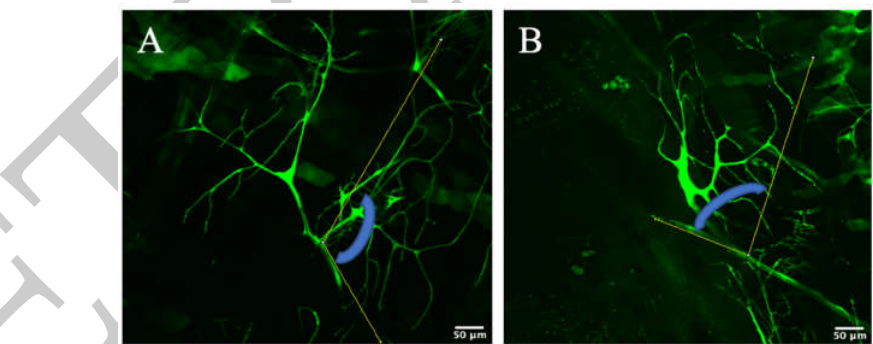
Figure 6. Examples of angle° analysis for branching morphogenesis. The angle is indicated by the blue arc that is drawn between the first yellow line, which is a constant line intersecting the two terminal cells, and the second yellow line encompassing the furthest visible branch for the terminal cell of interest. ( A ) represents such an angle from a control, ( B ) represents such an angle from a RNAi knockdown.